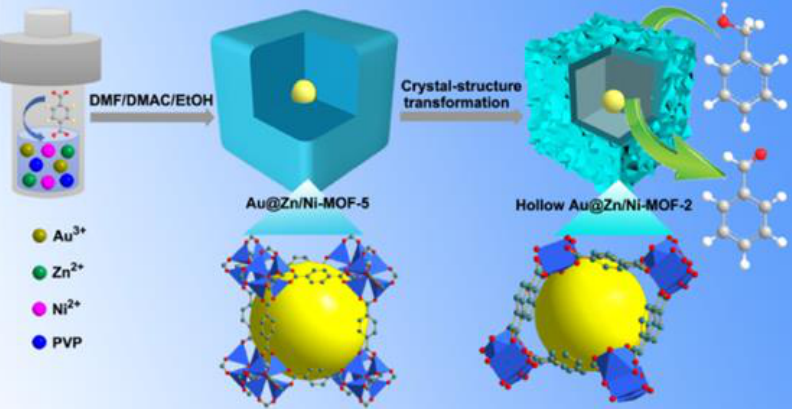
Figure 11. Fabrication of hollow Au@Zn/Ni – MOF – 2. Reprinted with permission from Ref. [66]. Copyright 2021, American Chemical Society.